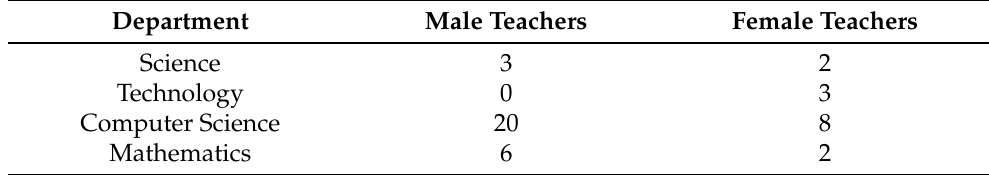
Table 2. Distribution of gender among the teachers from departments related to